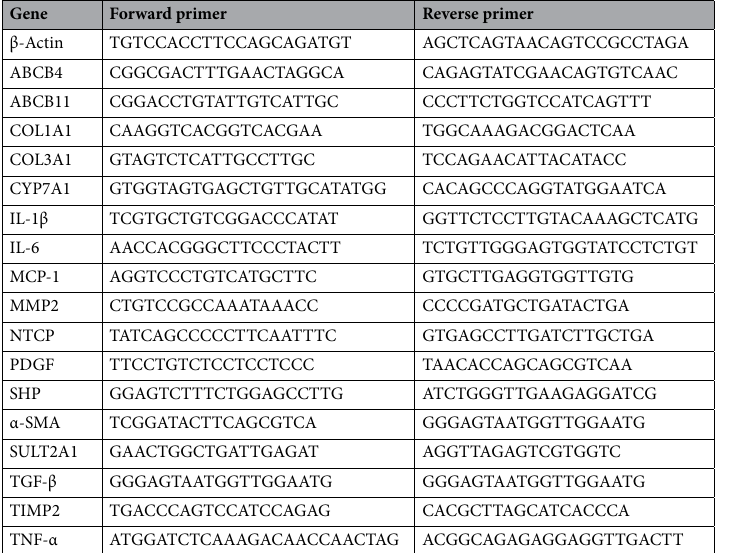
Table 1. List of primers in PCR